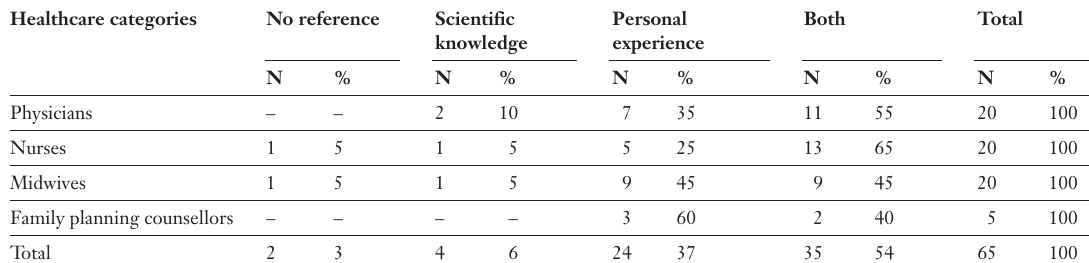
Contraception and social representation